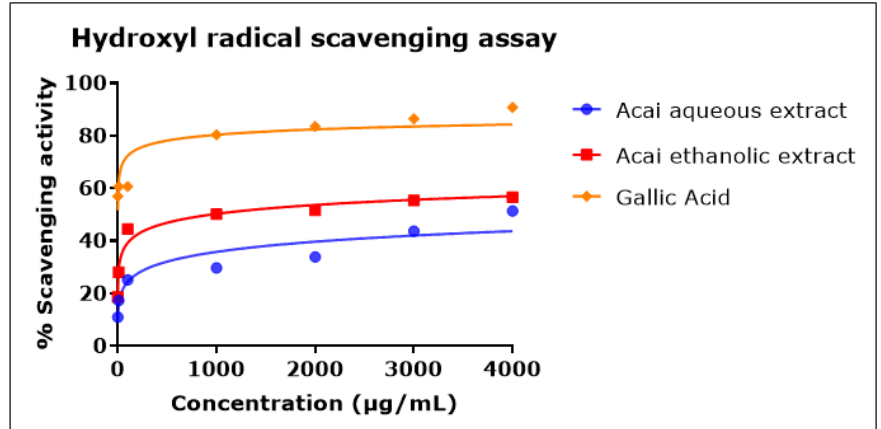
Figure 5. Hydroxyl radical scavenging activity of acai aqueous and ethanolic extracts. Acai antioxi-